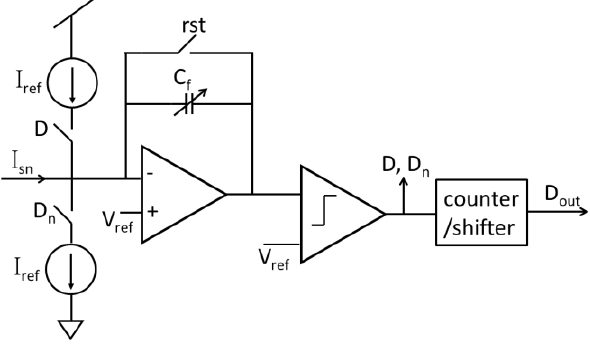
Figure 12. The structure of a first-order incremental current mode Σ∆ ADC circuit for amperometric sensing.